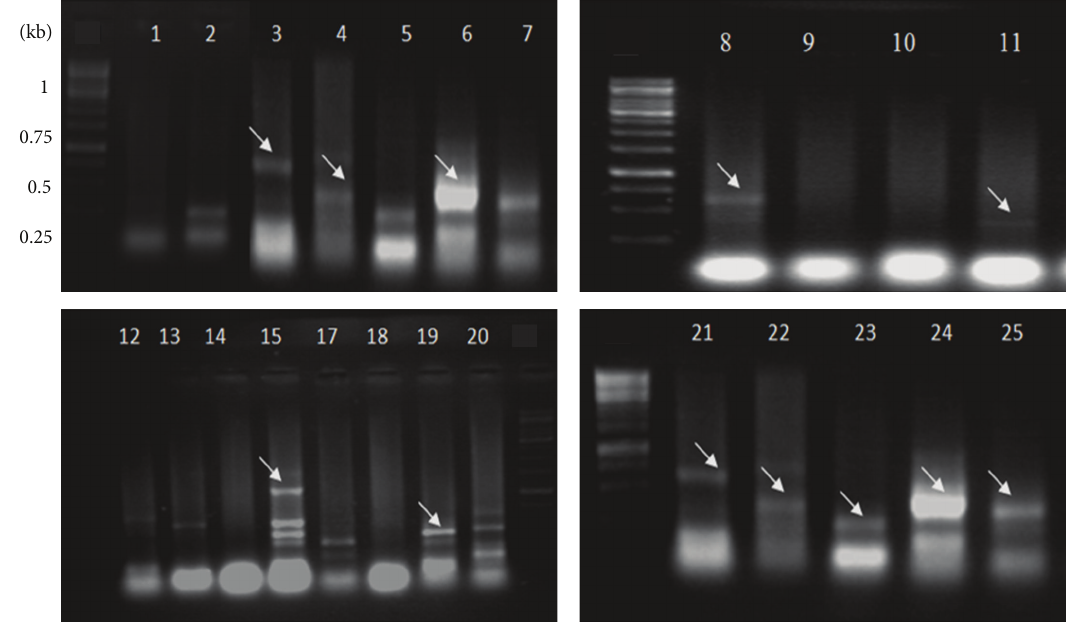
Figure 3: PCR amplification of the ARS from S. cerevisiae . Lane 1 is the control and in lane 3 428 bp band corresponds to the mol. wt. of the ARS315. Lane 4 represents the expected band of the 367 bp corresponding to ARS606. Bright band of 381bp representing ARS1512 (lane 6), 281 bp band corresponding to ARS1305 (lane 8), 328 bp band corresponding to ARS1426 (lane 15). Lanes 21–25 represent the reamplified ARS and lane 21 represents ARS315; lane 22, ARS606; lane 23, ARS1305; lane 24, ARS1512; and lane 25, ARS1426. Some primer combinations used did not yield desired products (lanes 2, 5, 7, 9, 10, 12, 13, 14, 17, 18, and 20). M is the 1kb molecular wt marker.